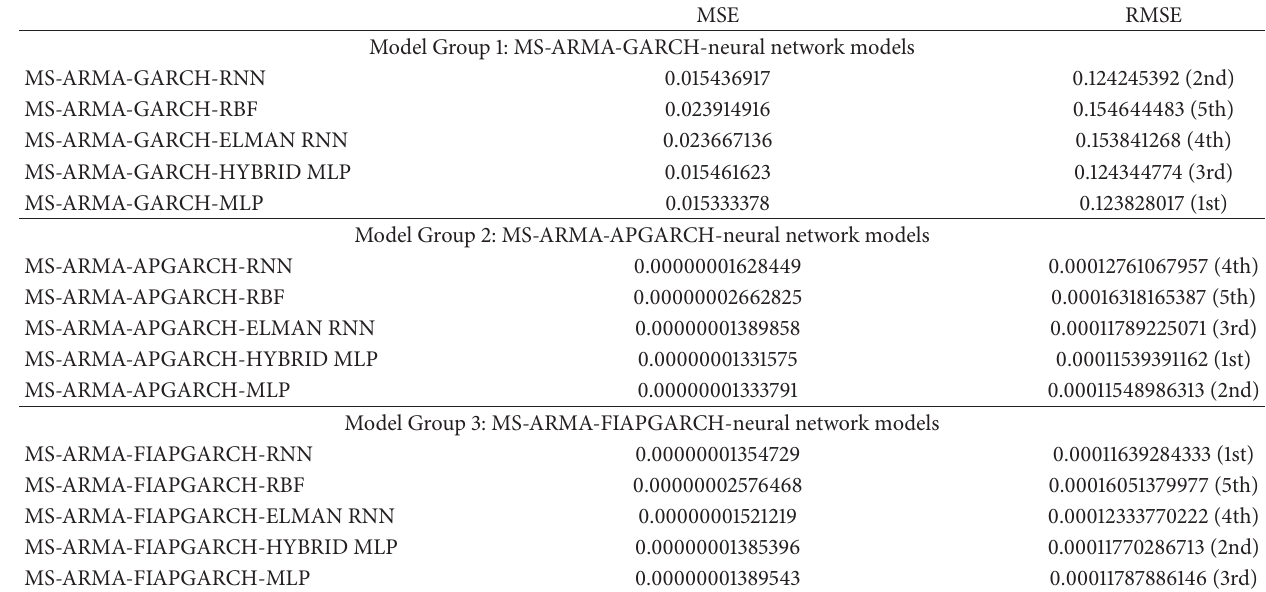
Table 6: Markov switching ARMA-GARCH neural network models: out of sample results. MSE RMSE Model Group 1: MS-ARMA-GARCH-neural network